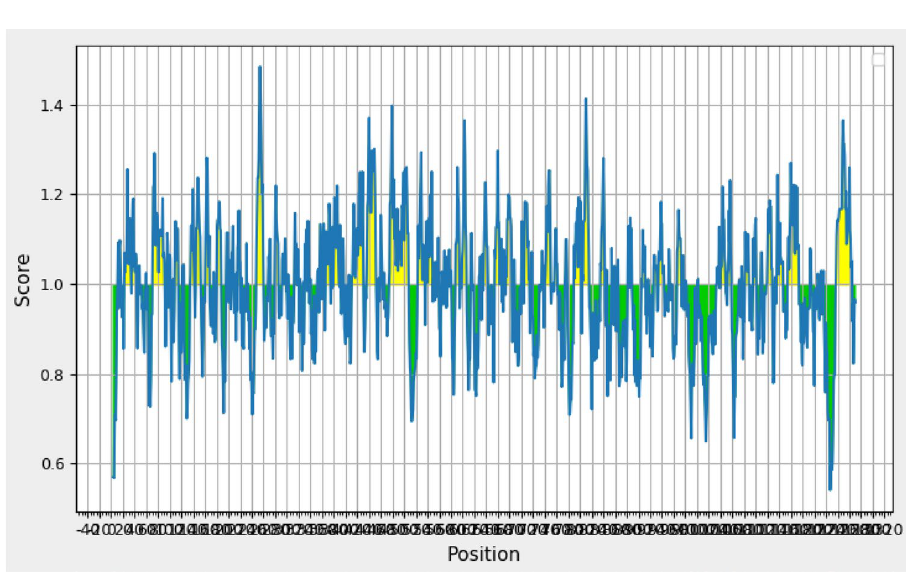
Figure 4. Good surface accessibility by Chou-Fasman method 35